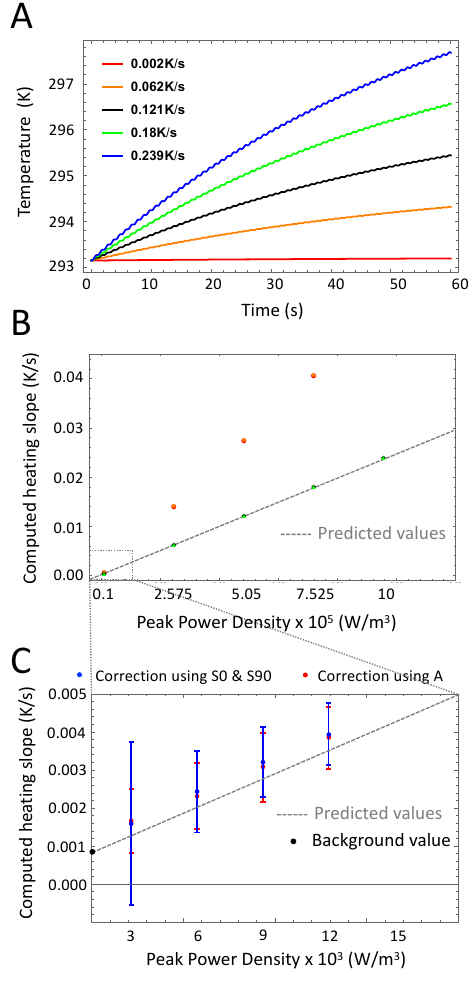
Figure 7. Variations of the heating slope. ( A ): Time-dependent temperature of the sample for different values of the heating slope. The heating slope influences the duration of the thermal relaxation phase as well as the signal amplitude. ( B ): Computed heating slope β (normalized) for different peak power density. Intuitively, the calculation using the amplitude is preferable in terms of sensitivity due to the ratio in Equation (12). ( C ): Extended view of the computed heating slope for low power values. Dots represent mean values whereas error bars the standard deviation, computed for 100 measurements. The black dot represents the experimental value of the background signal measured outside the